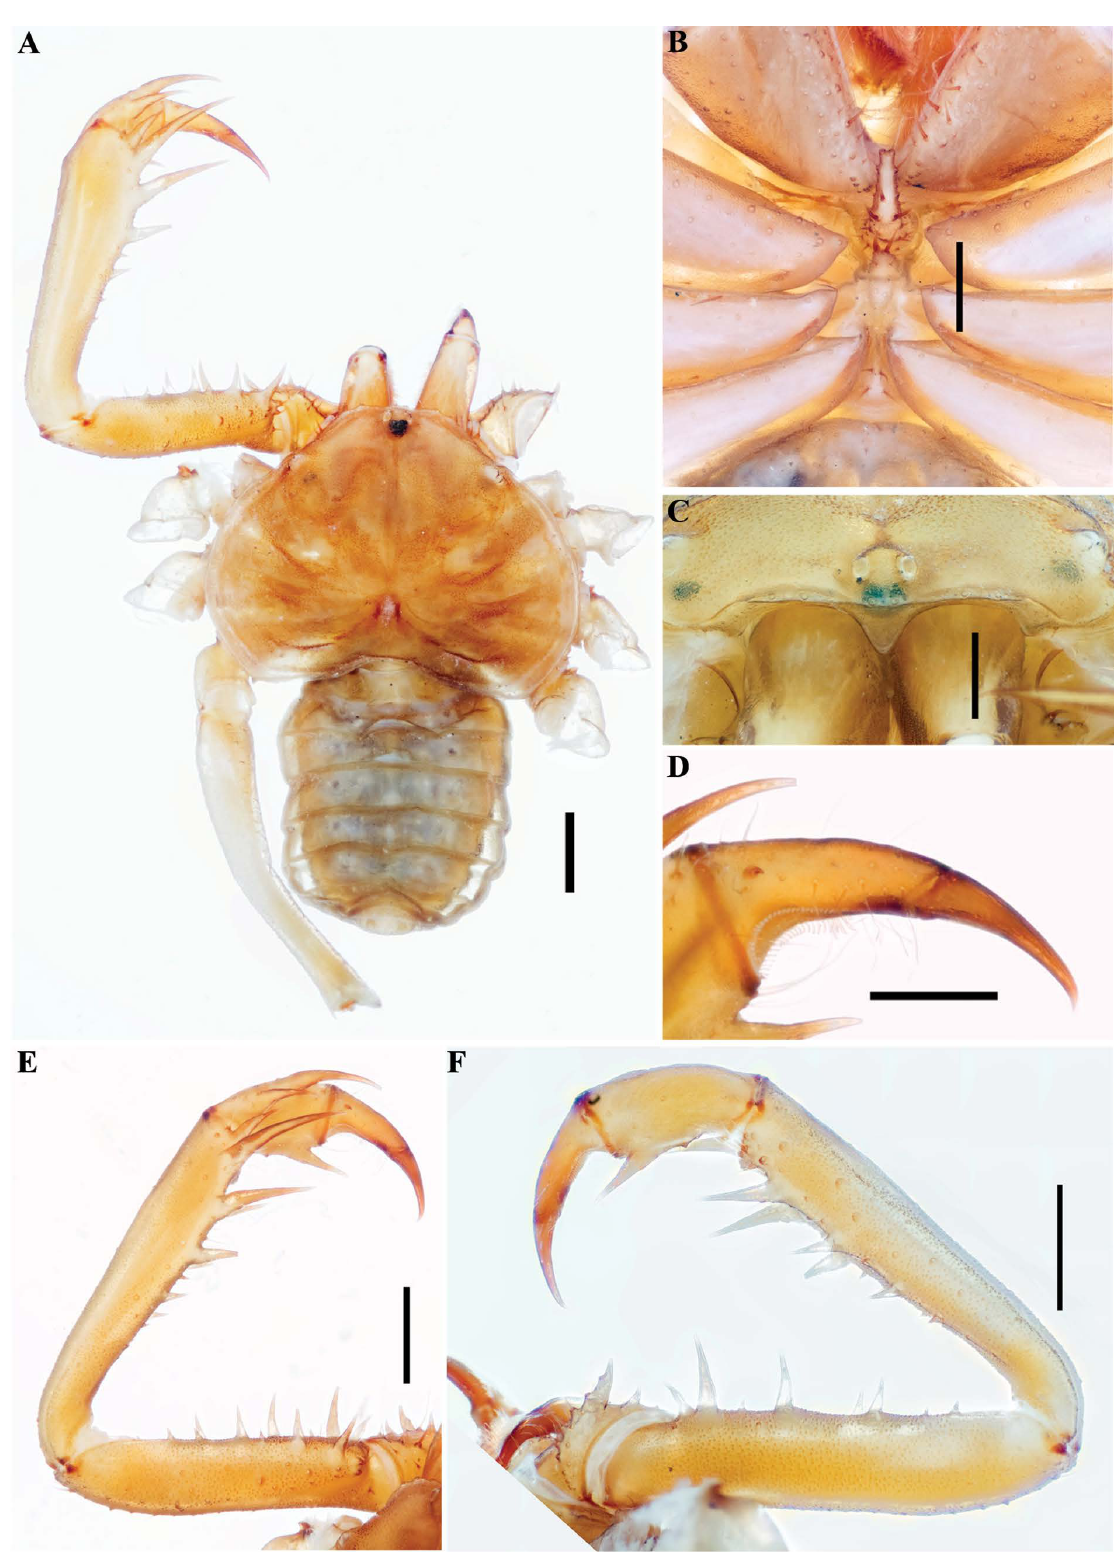
Fig. 109. Sarax dunni sp. nov. (NMNZ), general morphology, ♀. A . Habitus, dorsal view. B . Sternum, ventral view. C . Frontal process. D . Pedipalp tarsus, frontal view. E . Pedipalp, dorsal view. F . Pedipalp, ventral view. Scale bars: A, E–F = 1 mm; B–D =